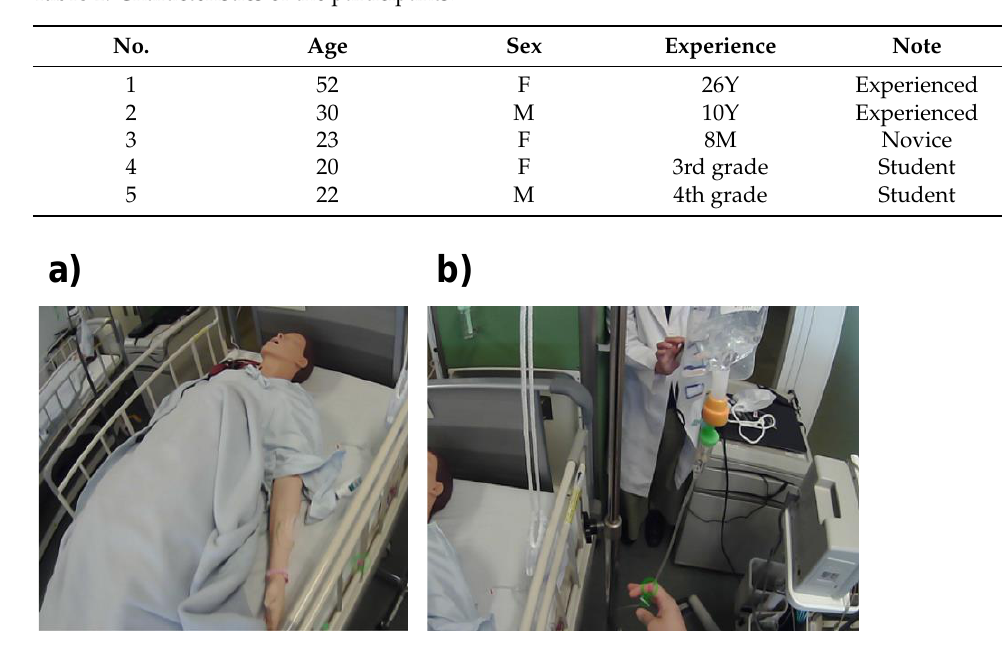
Figure 2. Environment for the eye-tracking tasks. ( a ) Human patient simulator and ( b ) continuous infusion.